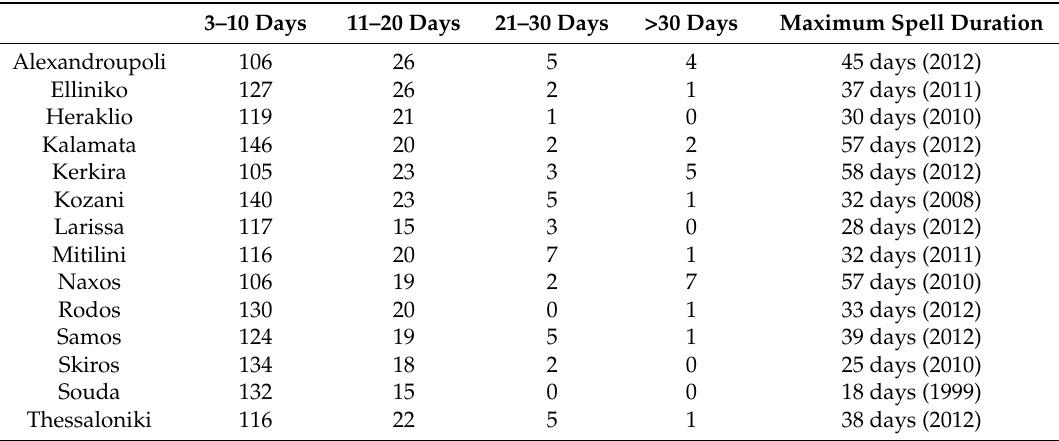
Table 2. Number of heat wave spells (consecutive days with EHF values > 0.0) during the study period 1958–2012 for the 14 stations under